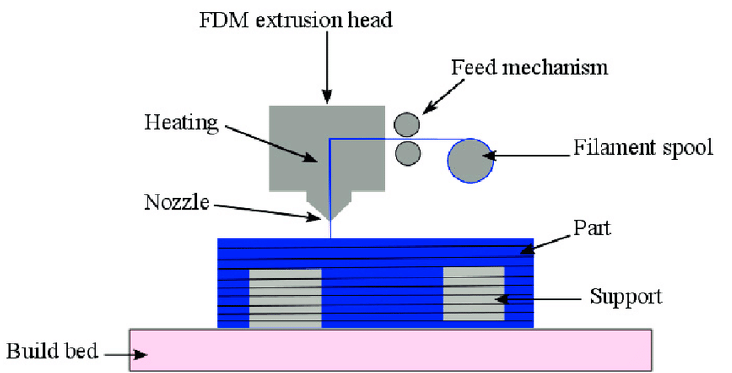
Figure 4. Fused deposition modeling (FDM) process (adapted with permission from reference [24]).